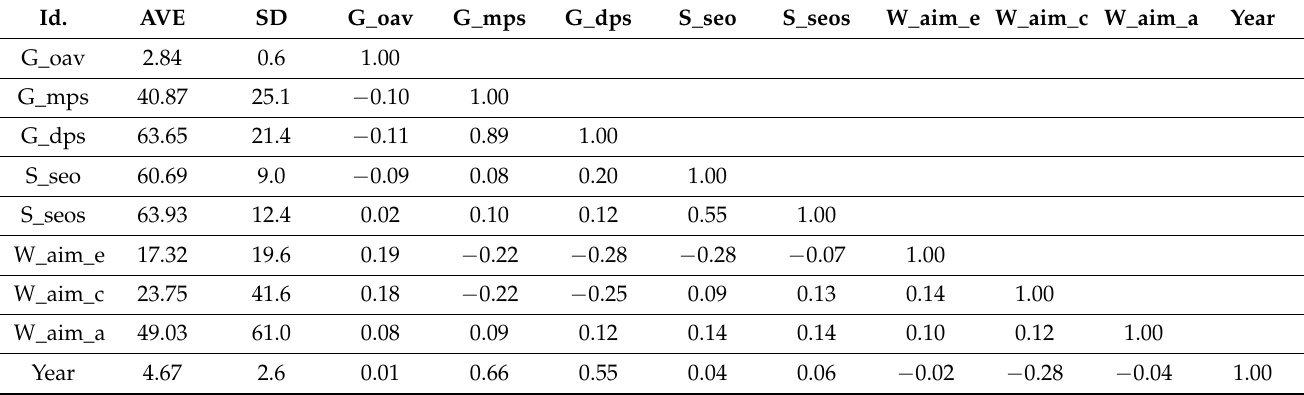
Table 6. Correlations between website quality assessment